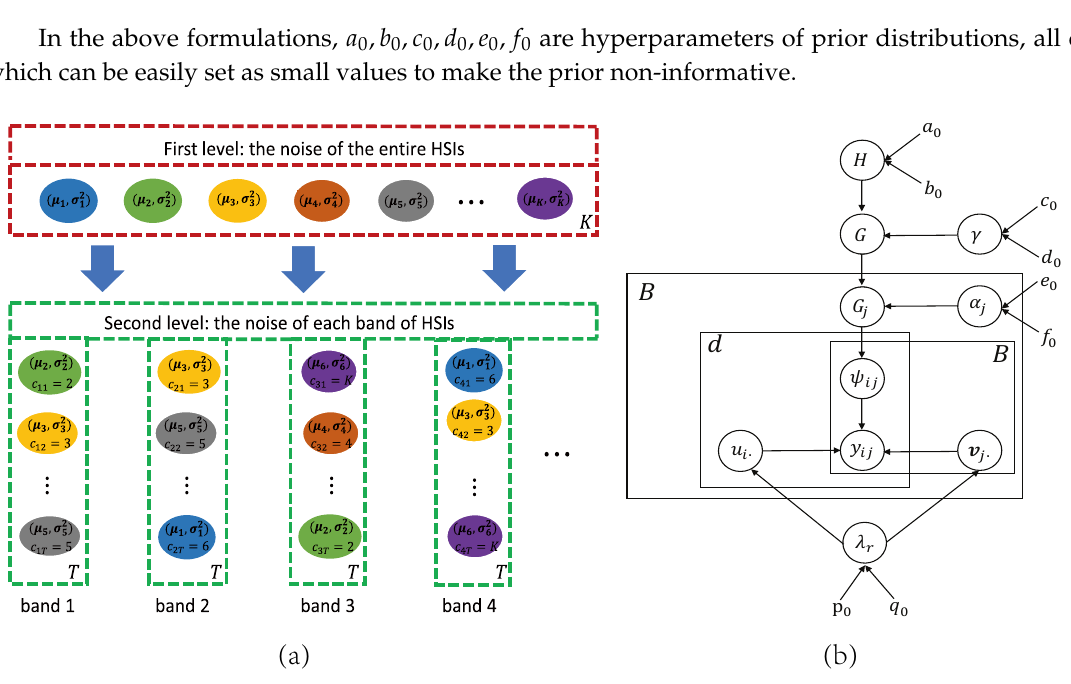
). The green dotted rectangles, k